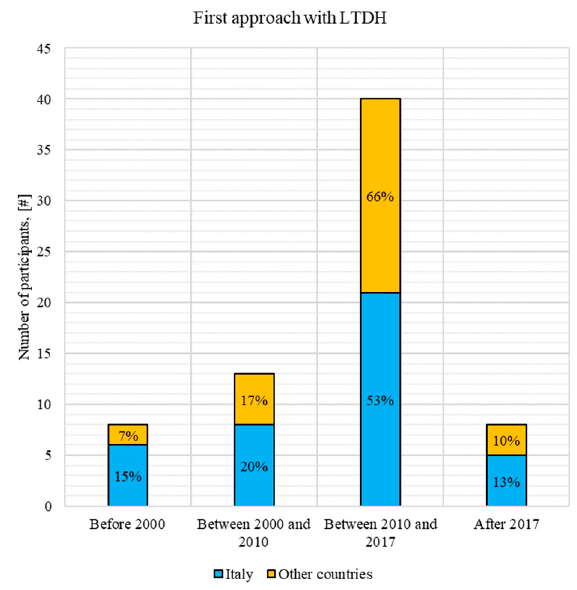
Figure 7. First exposure to the LTDH concept.